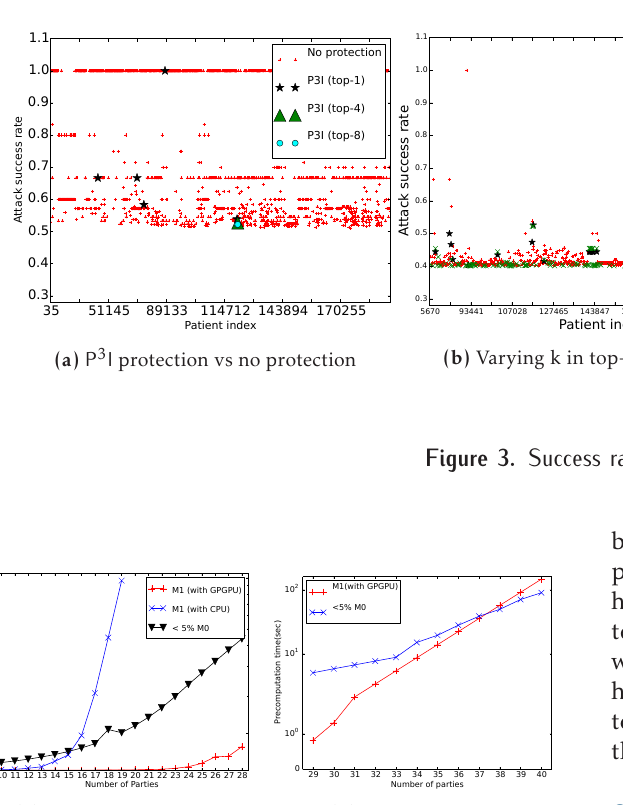
Micro-benchmark of Pre-computation. The